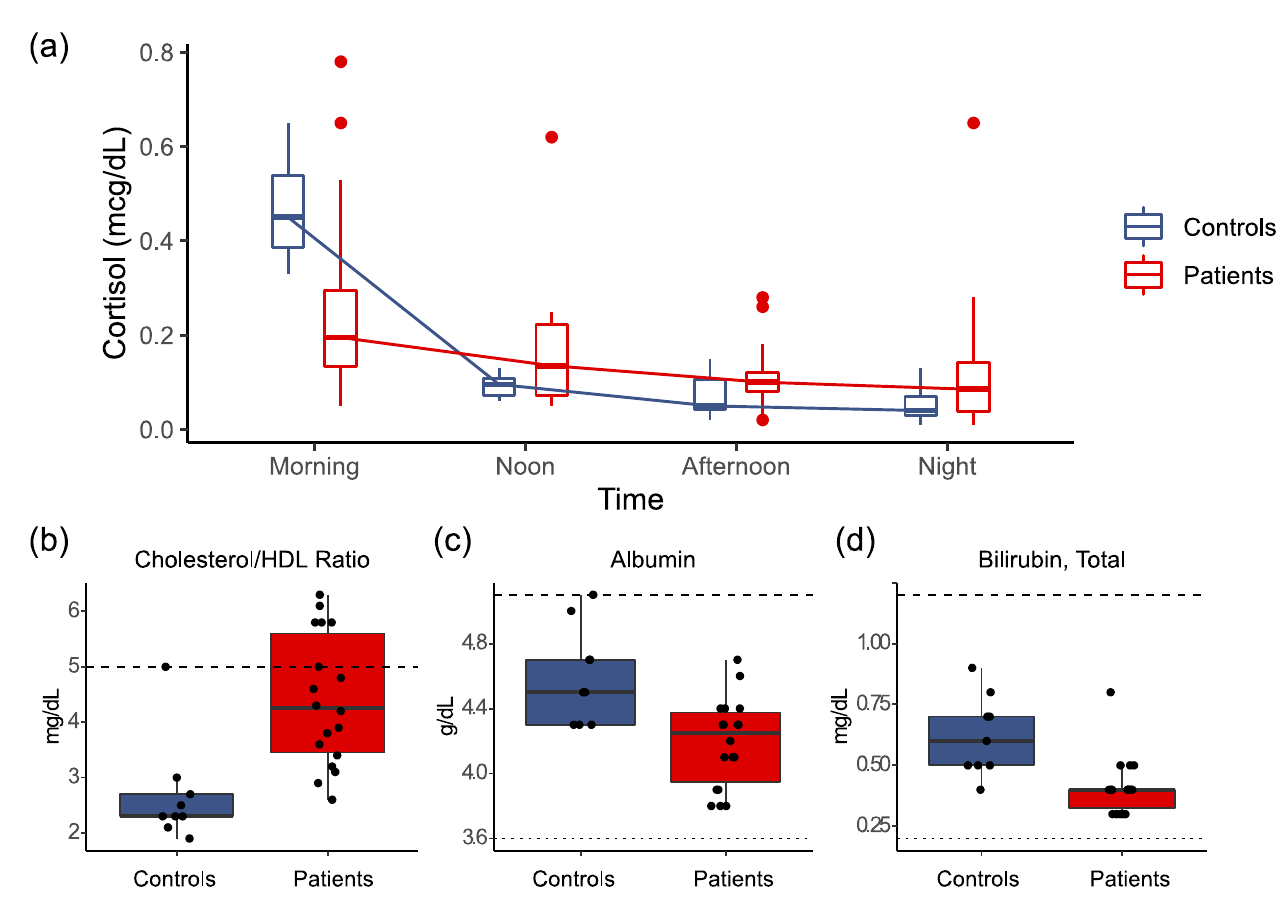
Figure 4. Clinical Lab Test Results Significantly Different between Severe ME/CFS and Controls. ( a ) Results of 4-point salivary cortisol upon wakening, at noon, afternoon, and night. The severe patients demonstrated significantly lower salivary cortisol concentrations in the morning and a significant flattening of the diurnal cortisol profile. ( b – d ) Results of a significantly higher level of cholesterol/HDL ratio ( b ), lower level of albumin, ( c ) and lower total bilirubin, ( d ) in the blood of the patients than of the controls.